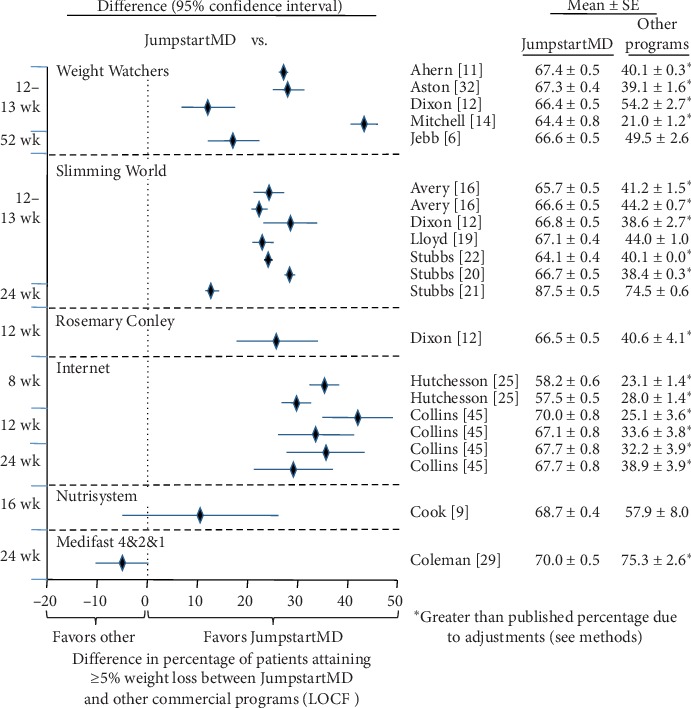
Mean LOCF weight loss difference between JumpstartMD and other commercial programs as measured by percent attaining ≥5% weight loss. Positive differences designate greater JumpstartMD weight loss. See legend to Figure 5 for further explanation.